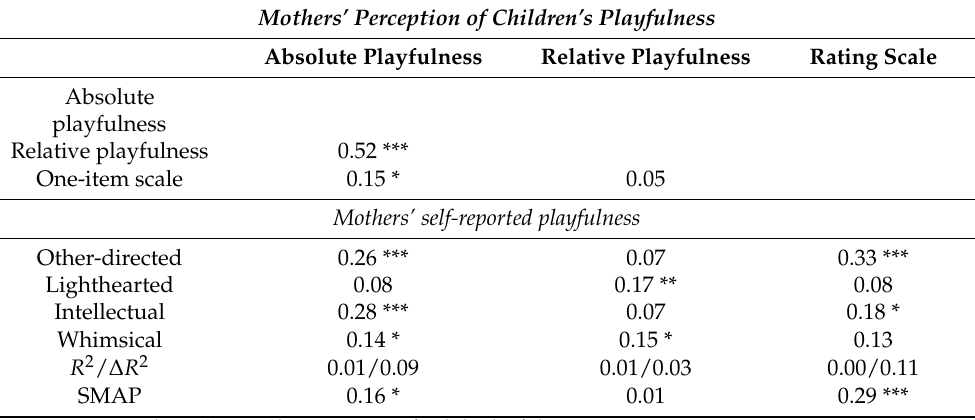
Table 2. Intercorrelations of mothers’ perceptions of their children’s playfulness and their correlations with mothers‘ self-reported playfulness while controlling for mothers’ age and relationship